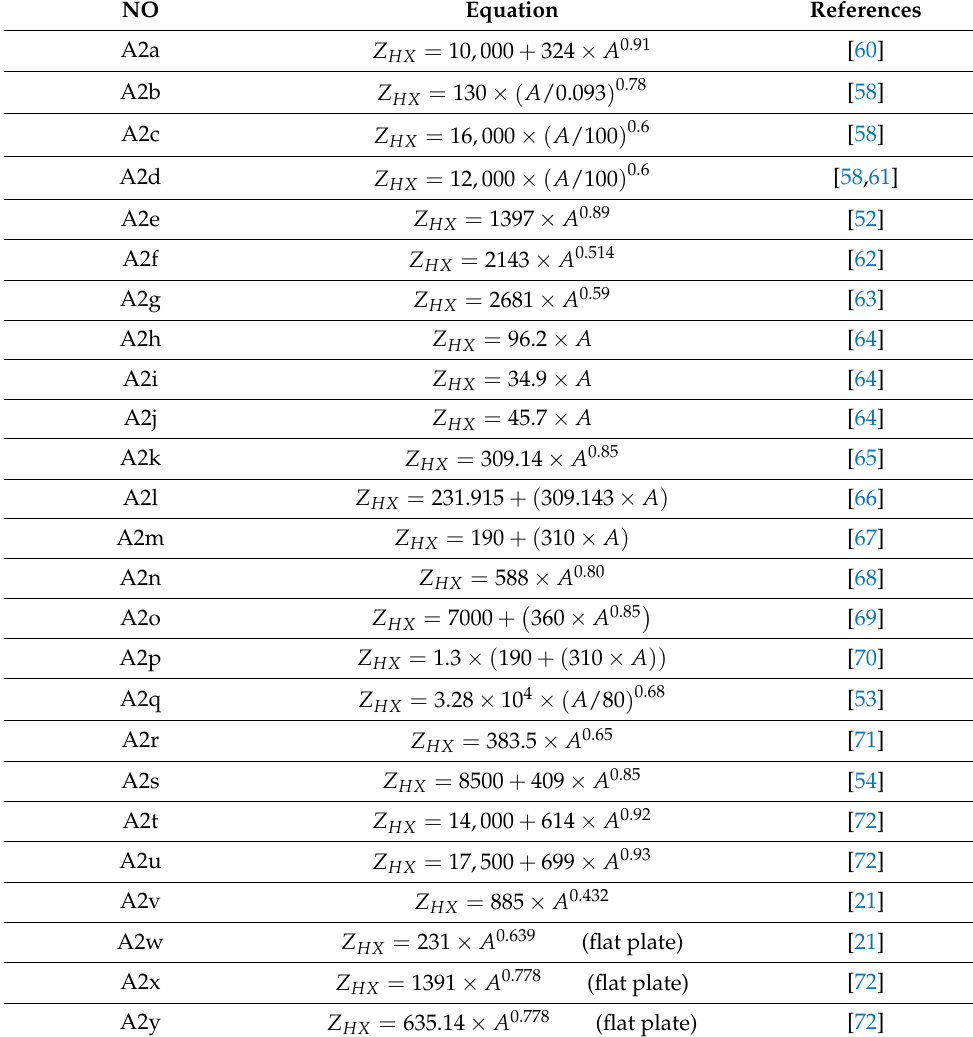
Table A2. Heat exchanger purchasing cost equations.